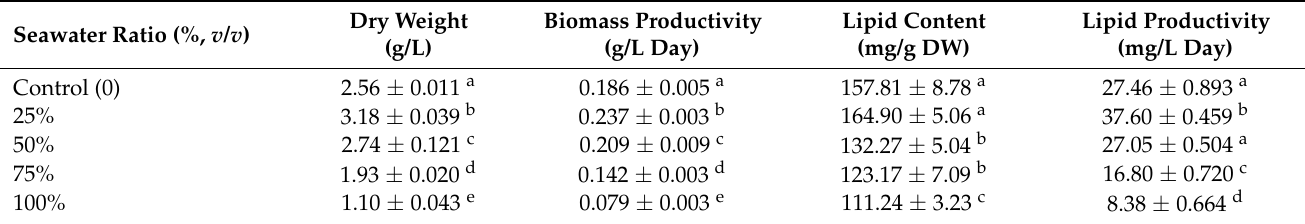
Figure 2. Effect of different seawater ratios on growth of Chlorella sp. cultivated for 20 days in synthetic wastewater. Table 2. Effect of different seawater ratios on biomass and lipids of Chlorella sp. cultivated in synthetic wastewater and harvested at the late exponential